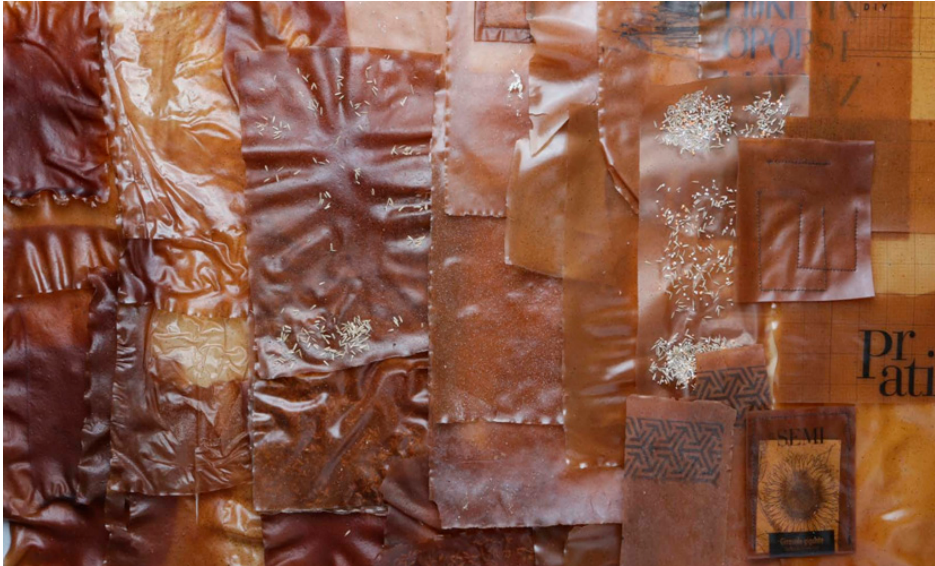
Figure 4. Coupling of the different films strips with lawn seeds prepared for application.